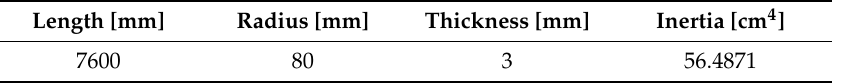
Table 5. Third test–geometrical parameters.